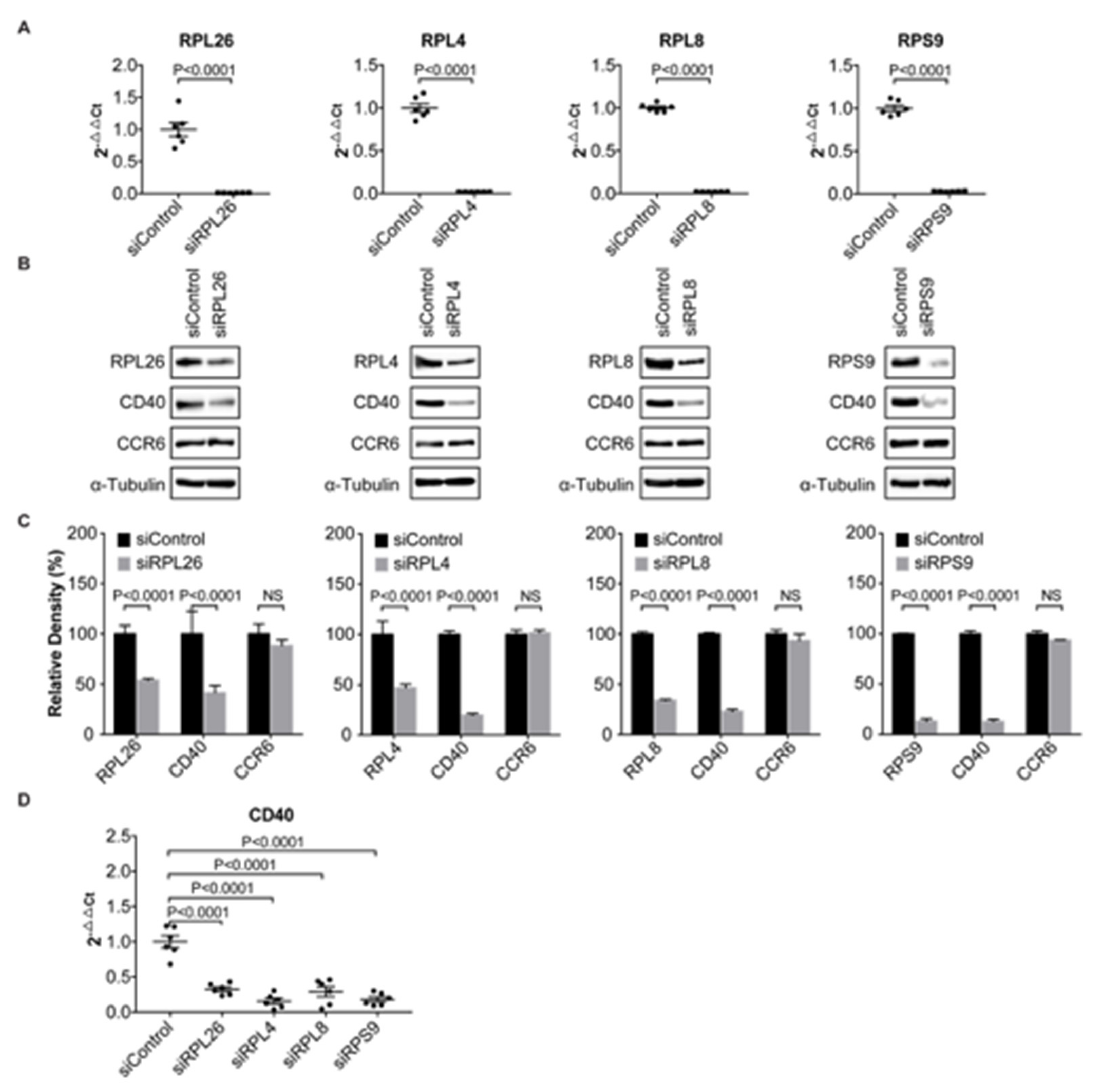
Figure 2. Demonstration of RPL26, RPL4, RPL8 , and RPS9 as CD40 transcription regulators in human FLS. ( A ) Real time PCR showing downregulation of RPL26 , RPL4 , RPL8 , and RPS9 in FLS by siRNA. ( B ) Western blot showing reduced CD40 expression in RPL26, RPL4, RPL8 , and RPS9 knockdown cells by siRNA. CCR6 was used as a negative control for translational regulation. ( C ) Statistical analysis of Western blots in ( B ) based on relative density. NS: not significant. ( D ) Real time PCR showing reduced CD40 expression in downregulation of RPL26, RPL4, RPL8, and RPS9 in FLS. si: siRNA. Here, we notice that, previously when we applied RNAi knockdown on RSRC2 gene in both human BL2 cells and FLS, we observed an induction of CD40 expression [9], suggesting that RSRC2 is a CD40 transcriptional suppressor. RSRC2 is one of the eight genes in the complex that bind to the fSNP